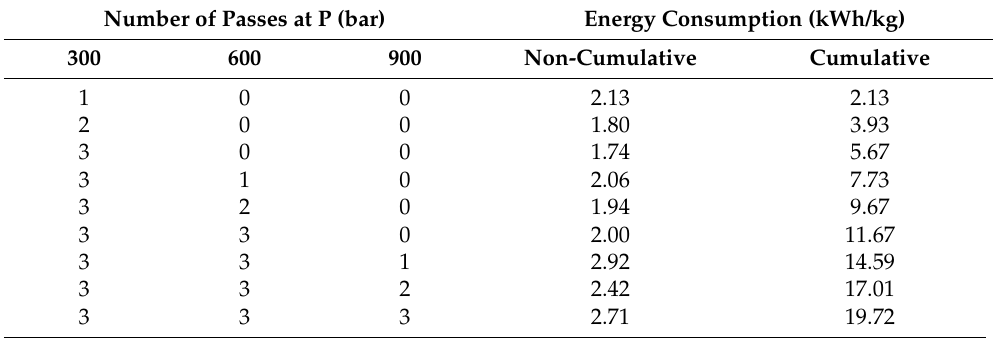
Table A4. Energy consumption for each of the homogenization cycles, depending on the pump pressure. Number of Passes at P (bar)